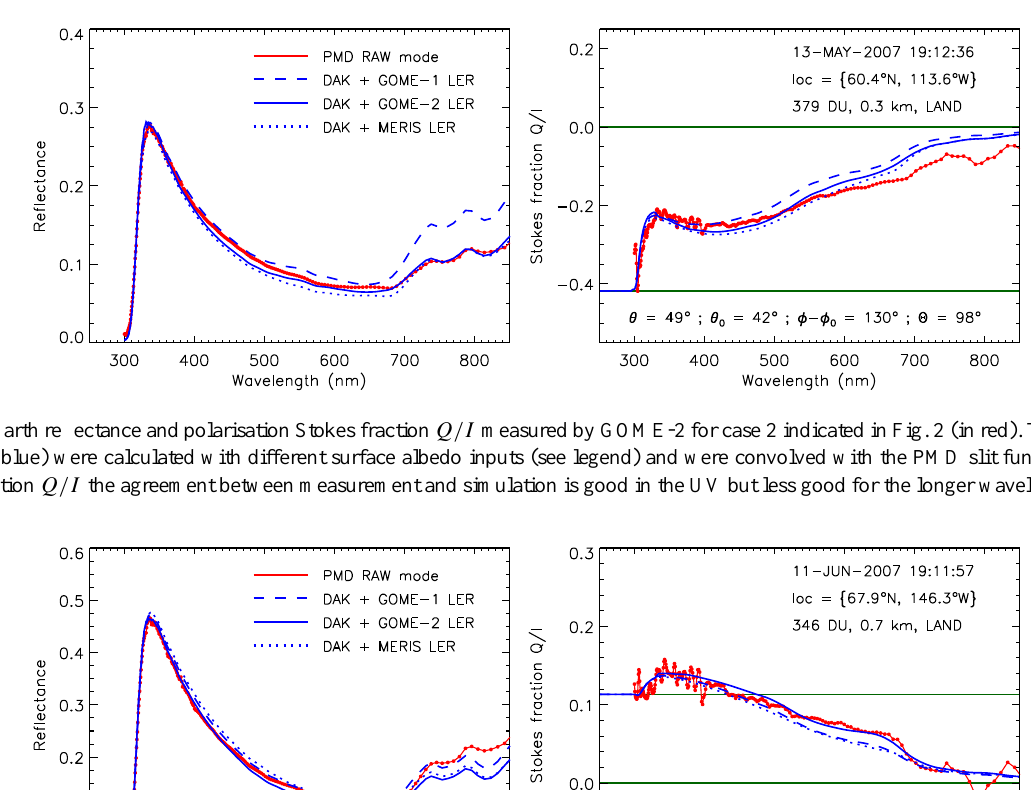
Fig. 3. Earth reflectance (left window) and polarisation Stokes fraction Q/I (right window) derived from GOME-2 PMD RAW mode measurements for case “1” in Fig. 2 (in red). The green curves represent the high-resolution simulated reflectance and polarisation spectra, based on surface albedo input from the GOME-1 surface LER database. The dashed blue curve represent the same, but convolved with the PMD slit function. The FWHM of this slit function typically ranges between 3 nm in the UV up to 35 nm in the NIR. The solid and dotted blue curves also represent convolved simulation results but for these simulations the surface albedo input was taken from the GOME-2 and MERIS surface reflectivity databases, respectively. The two horizontal green lines in the right window indicate the unpolarised